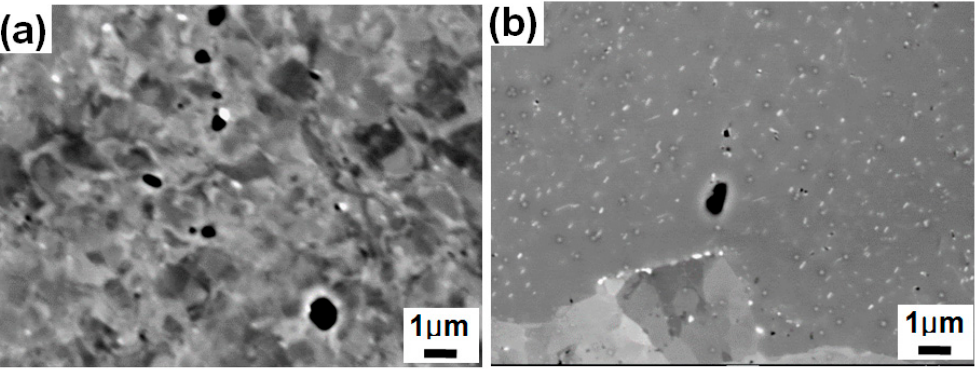
Figure 5. Counting inclusion using EPMA-BSE image ( a ) 28J and ( b ) 386J Specimen.